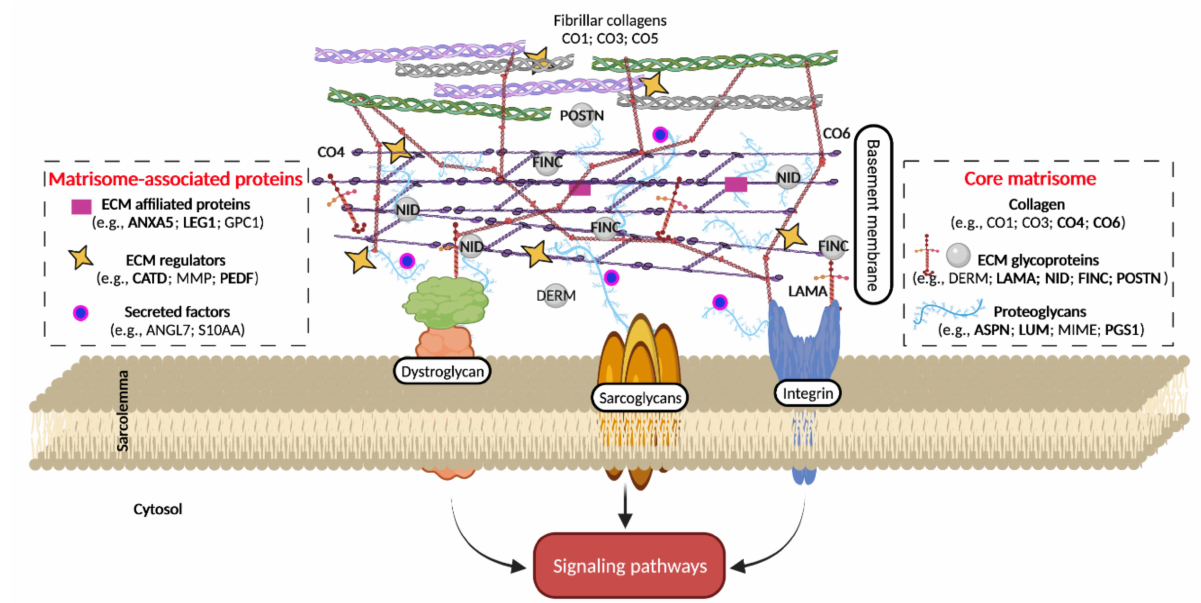
Figure 6. Schematic representation of matrix-sarcolemma axis of skeletal muscle fibre. Proteins differentially expressed between old and adult SM are reported in bold. ANGL7, angiopoietin-related protein 7; ANX, annexin; ASPN, asporin; CO, collagen; CATD, cathepsin D; DERM, dermatopontin; FINC, fibronectin; GPC1, Glypican 1; LAMA, laminin; LEG1, galectin 1; LUM, lumican; MMP, matrix metalloproteinase; MIME, mimecan; NID, nidogen; PEDF, pigment epithelium- derived factor; PGS1, biglycan; POSTN, periostin; S10AA, protein